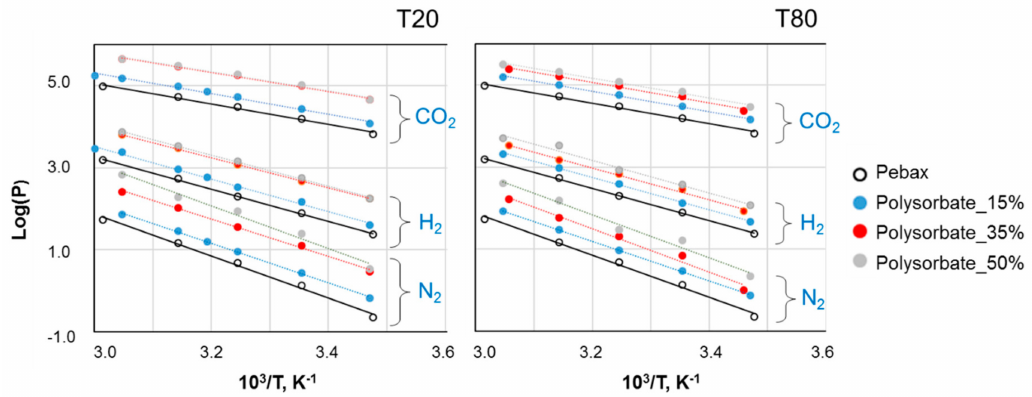
Figure 9. Permeability logarithm versus reciprocal of absolute temperature plot for CO 2 , H 2 , and N 2